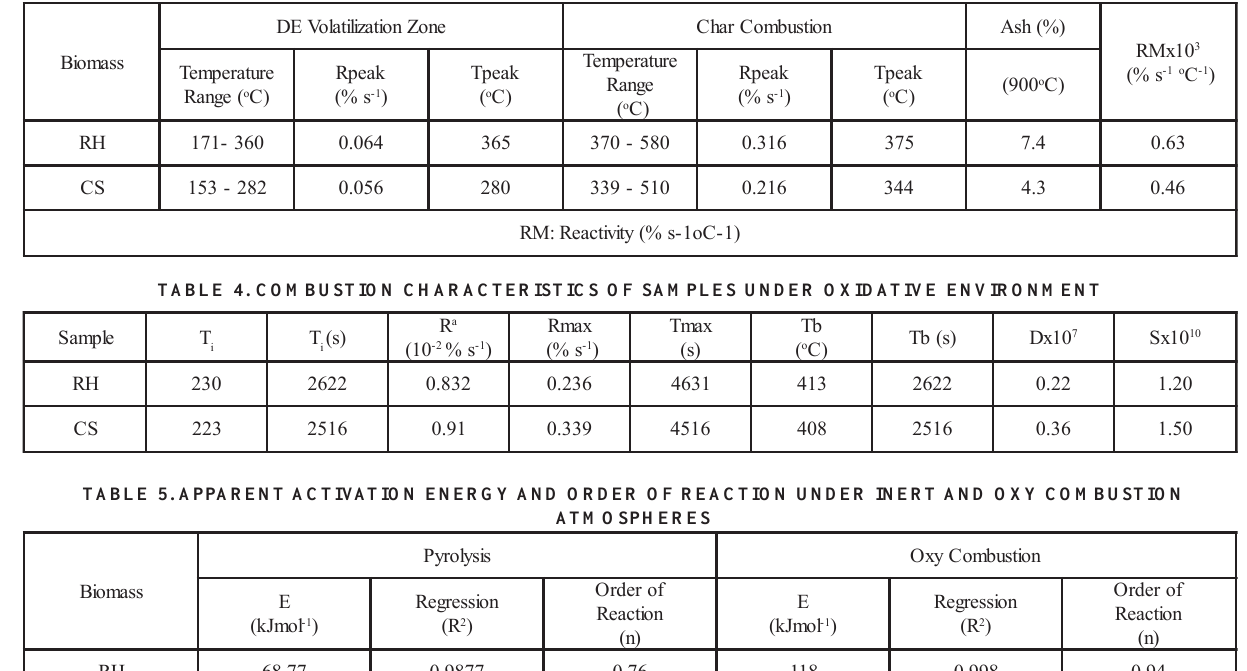
combustion index (S). The CS is more reactive material than RH. The apparent activation energy and order of reaction is shown in Table 5. TABLE 3. KINETIC BEHAVIOR OF TGA EXPERIMENTS UNDER OXIDATIVE ENVIRONMENT